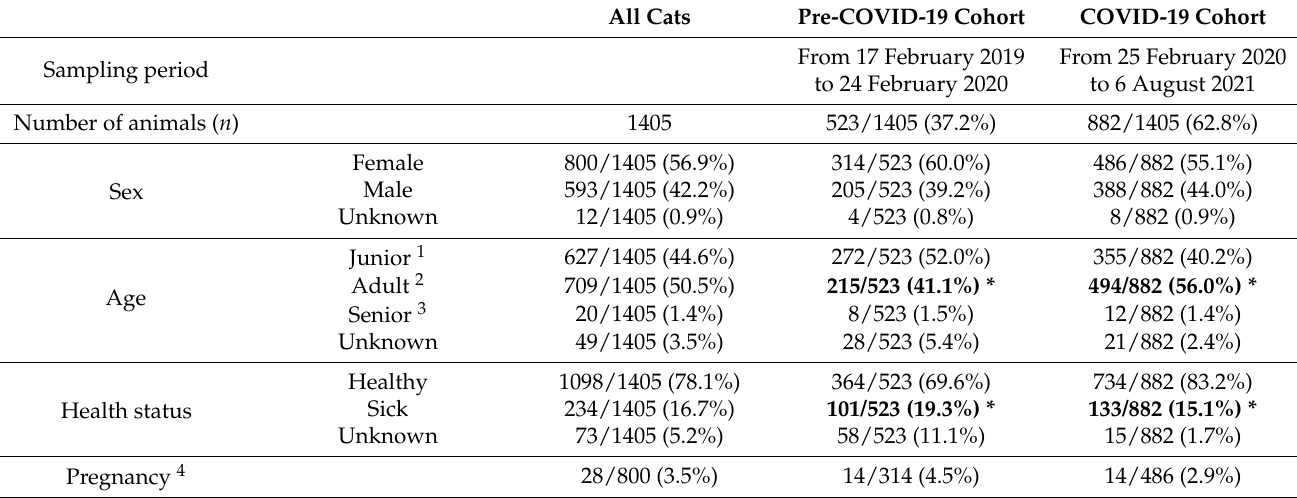
Table 1. Sample characteristics of all cats and cats categorized into the pre-COVID-19 and COVID-19 cohorts: number of animals, sex, age, health status, and presence of pregnancy. All